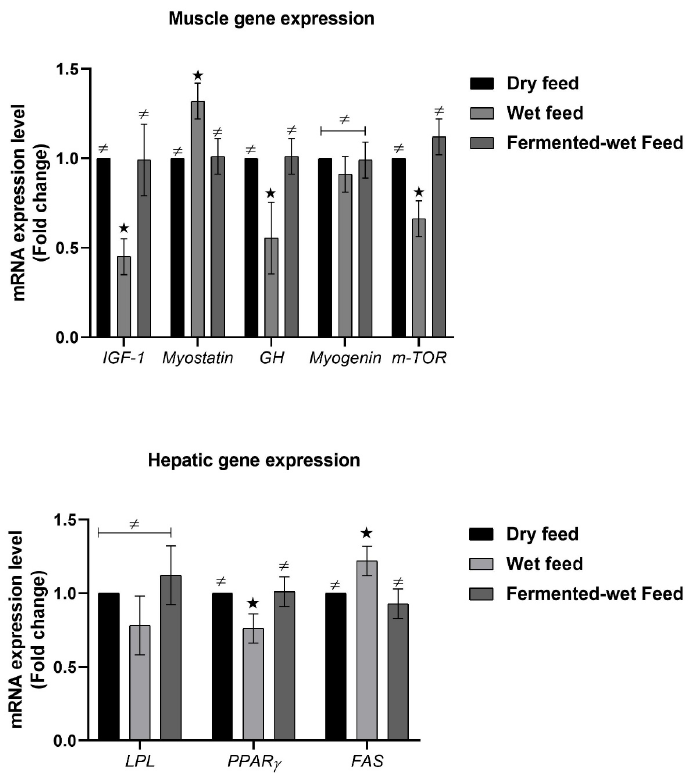
Figure 5. Reverse transcription-polymerase chain reaction (RT-PCR) validation of hepatic lipoprotein lipase ( LPL ), peroxisome proliferator-activated receptor γ ( PPAR γ ) and fatty acid synthase ( FAS ), and muscular myostatin, myogenin, mammalian target of rapamycin ( mTOR ), insulin growth factor 1 (IGF1) and growth hormone ( GH ) of 35-day-old broiler chickens as affected by dry, wet and fermented wet feeds. Data are presented as the mean values with their standard errors. (≠) indicates no significant changes, (*) indicates ( p < 0.05). Asterisk located above the columns indicates significance between different treated groups and the wet feed group. ( n = 8).